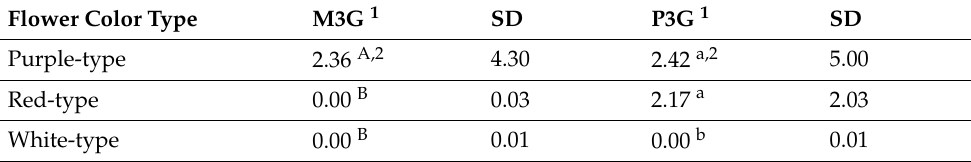
Table 3. Concentrations of peonidin-3-glucoside and malvidin-3-glucoside in petiole tissues of eastern